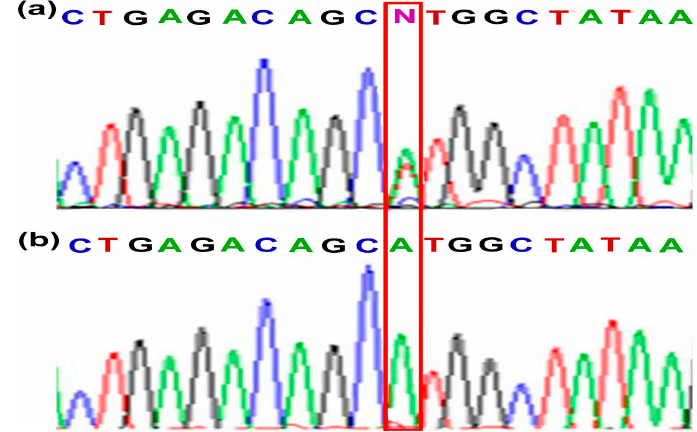
Figure 2. KDR mutation (g. 55972974 T > A) was validated by Sanger DNA sequencing of cSCC specimens: ( a ) heterozygous mutation ( b ) homozygous mutation.